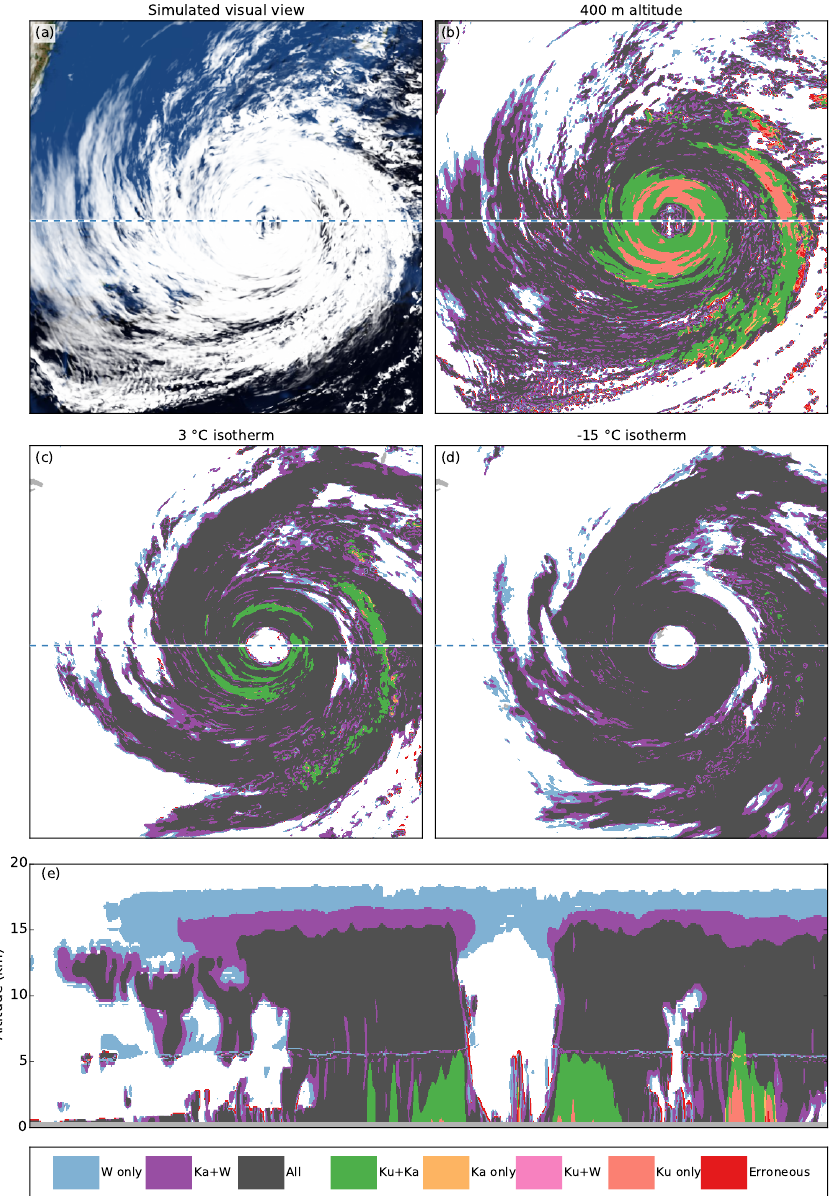
Figure 10. As in Fig. 6, but for the tropical cyclone (Sect. 5.4; CYC in Fig.